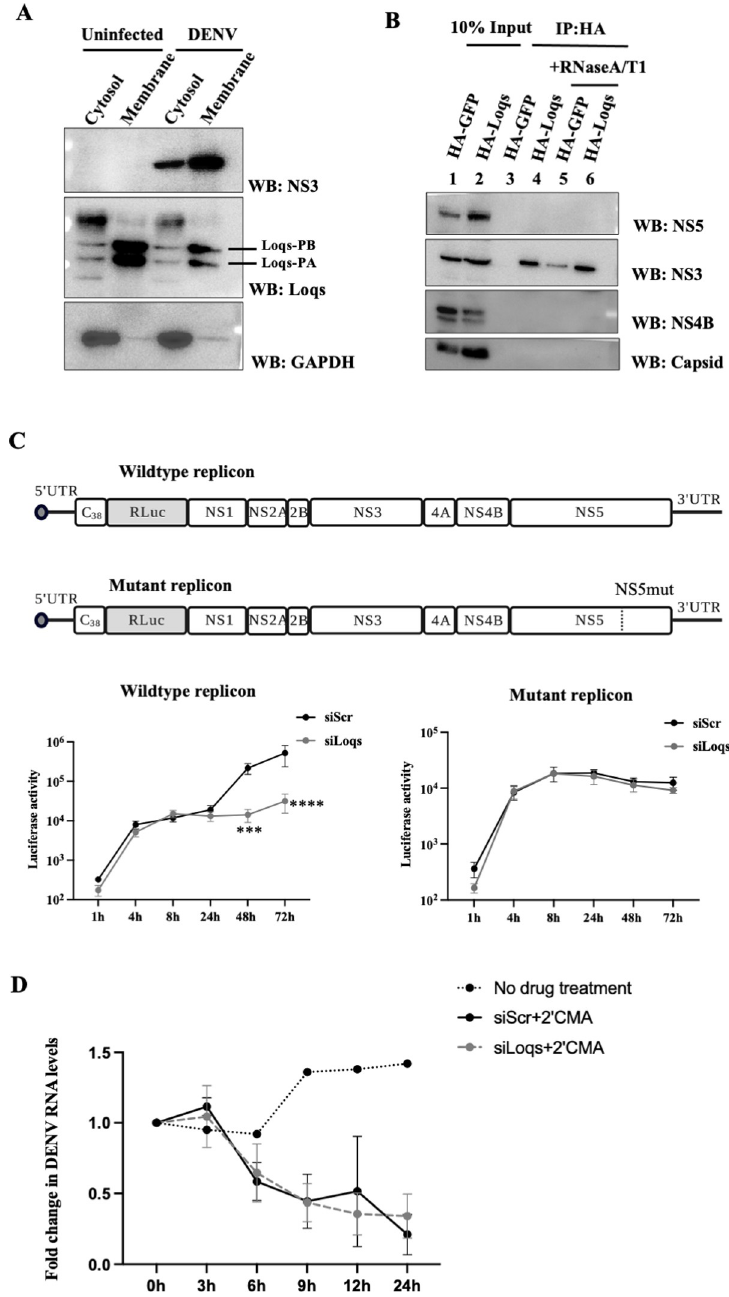
Fig 5. Effect of Loqs depletion on DENV RNA translation, replication and stability. (A) Western blot analysis of NS3, Loqs and GAPDH protein abundances in cytosolic and ER membrane fractions isolated from DENV2-infected Aag2 cell lysates at 72 hrs post infection. Representative image from three independent experiments is shown. (B) Immunoprecipitation of HA-tagged Loqs from Aag2 cells infected with DENV2 at a MOI of 1. Aag2 cells transfected with HA-GFP or HA-Loqs PA/PB plasmids were infected with DENV2 for 72 hrs and immunoprecipitations were performed with anti-HA antibody with or without RNaseA/T1 treatment. The abundances of DENV NS3, NS4B and capsid proteins in the immunoprecipitated material (IP) and the input lysates (10%) were determined by western blot analysis. (C) Luciferase activities of wildtype and replication-defective DENV2 luciferase replicons in C6/36 cells transfected with control siRNAs or siRNAs against Loqs (siLoqs-4 and siLoqs-5 were used at a final concentration of 25nM each). C6/36 cells were transfected with the indicated siRNAs followed by wildtype or replication-defective (NS5-GDD) replicon RNAs and harvested at the indicated time points. Average luciferase expression from DENV replicons from six independent replicates is shown ( ��� p < 0.005, ���� p < 0.0001). (D) Effect of Loqs depletion